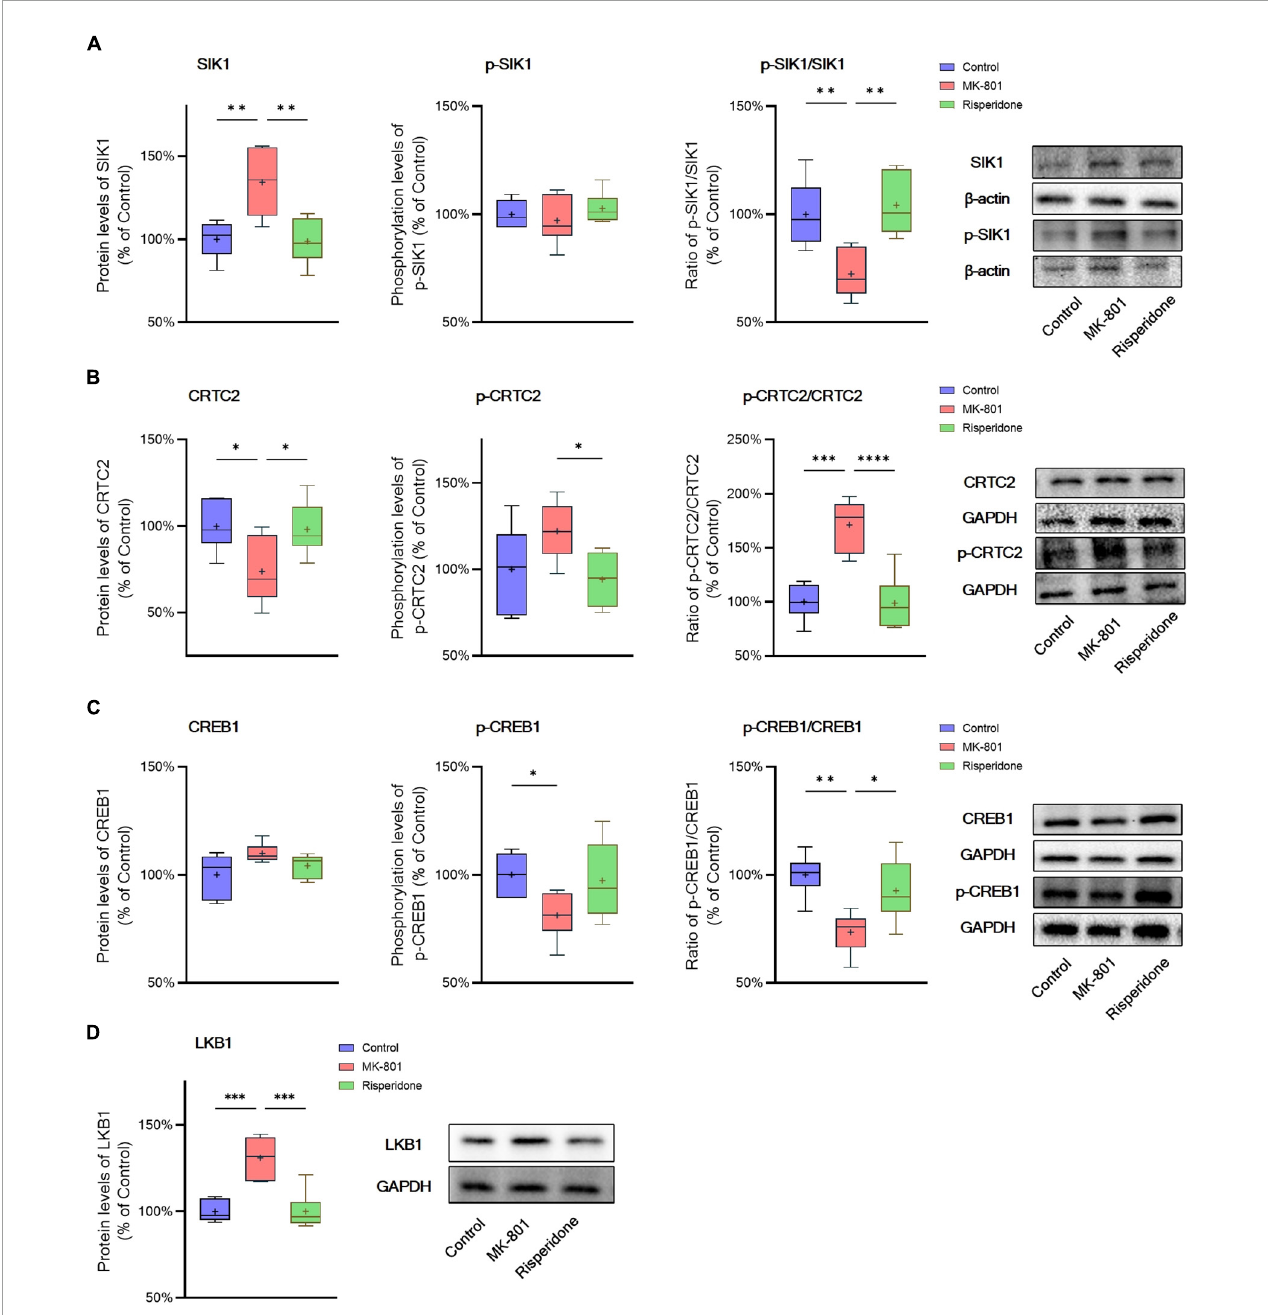
FIGURE3 Altered SIK1/CRTC2/CREB1 signaling induced by the repeated MK-801 administration in the prefrontal cortex. (A) The SIK1 phosphorylation was repressed by the MK-801 administration. (B) The CRTC2 phosphorylation in the model rat prefrontal cortex (PFC) was elevated, and reduced to near normal levels by risperidone. (C) The CREB1 phosphorylation CREB1 in the model rat PFC was down-regulated, but restored by risperidone. (D) The LKB1 protein expression was up-regulated by the MK-801 administration, but reversely regulated by risperidone. ∗ P < 0.05, ∗∗ P < 0.01, ∗∗∗ P < 0.001, ∗∗∗∗ P < 0.0001, + mean